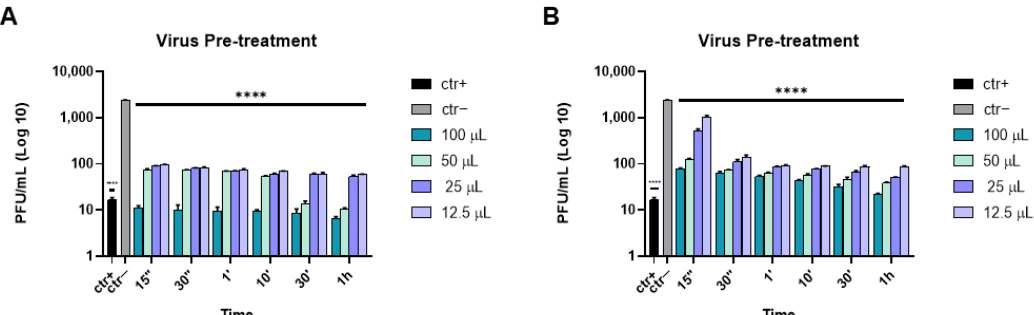
Figure 2. Virus pre-treatment assay of the antiviral activity of ophthalmic solutions against HSV-1 at different times of incubation. Iodim ( A ) and Ozodrop ( B ) were first incubated with HSV-1, and then the mixture was used to infect Vero cells. Melittin [35] was used as a positive control (ctr+). Data are means of three independent experiments. Statistical analyses were determined by two-way ANOVA, followed by a Bonferroni post hoc test. Significance refers to the negative control (ctr – ), i.e., the infected cells. **** p < 0.0001.